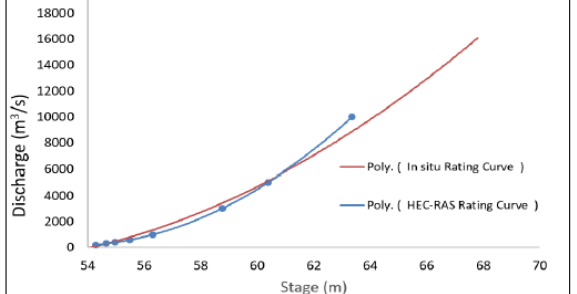
Figure 9. Comparion of In-situ and HD model based rating curve